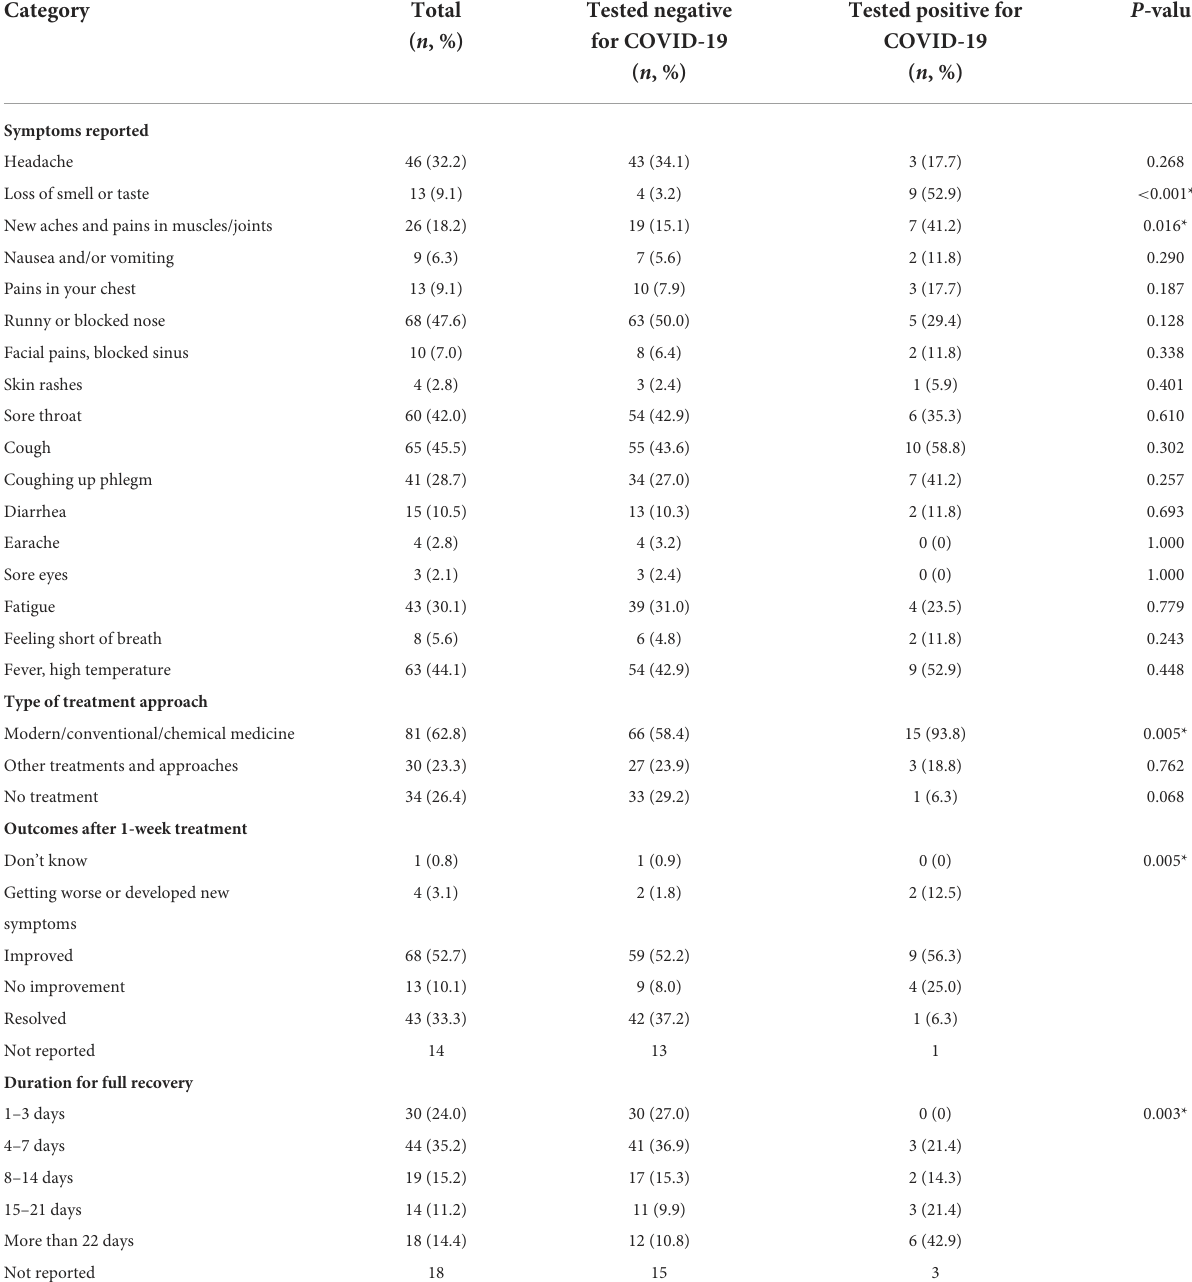
TABLE 4 Symptoms and treatment measures reported by survey respondents with symptoms, tested COVID-19 positive or